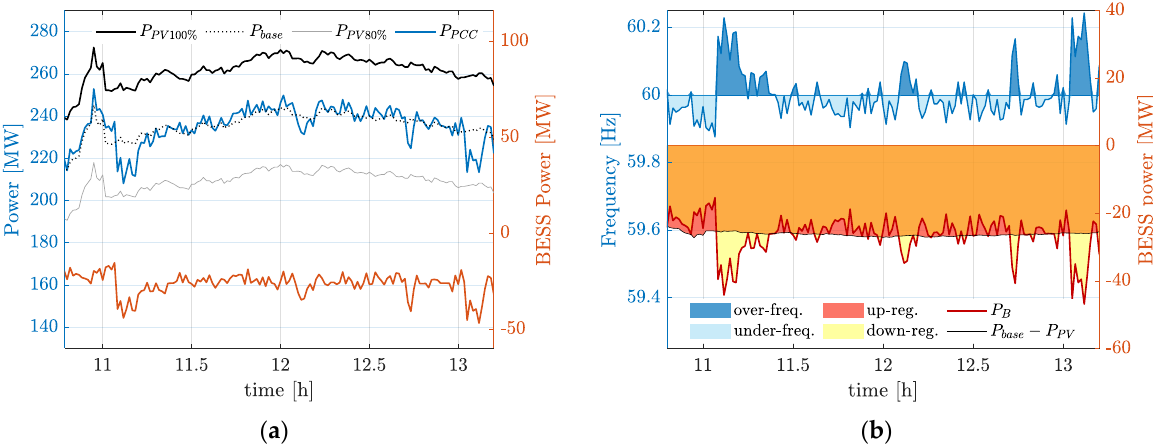
Figure 5. Result of PFR on the plant’s power flows. ( a ) on the left axis: black—100% of P PV ; dot black— P base (90% of P PV ); blue— P PCC ; grey—80% of P PV ; on the right axis: red—BESS power. ( b ) on the left axis: grid frequency with an over- (blue area) and under-frequency (light-blue area) occurrences. On the right axis, the battery power profile (red) and the battery “base” power (black). The red area depicts the provided upward energy reserve, and the yellow area depicts the downward reserve.